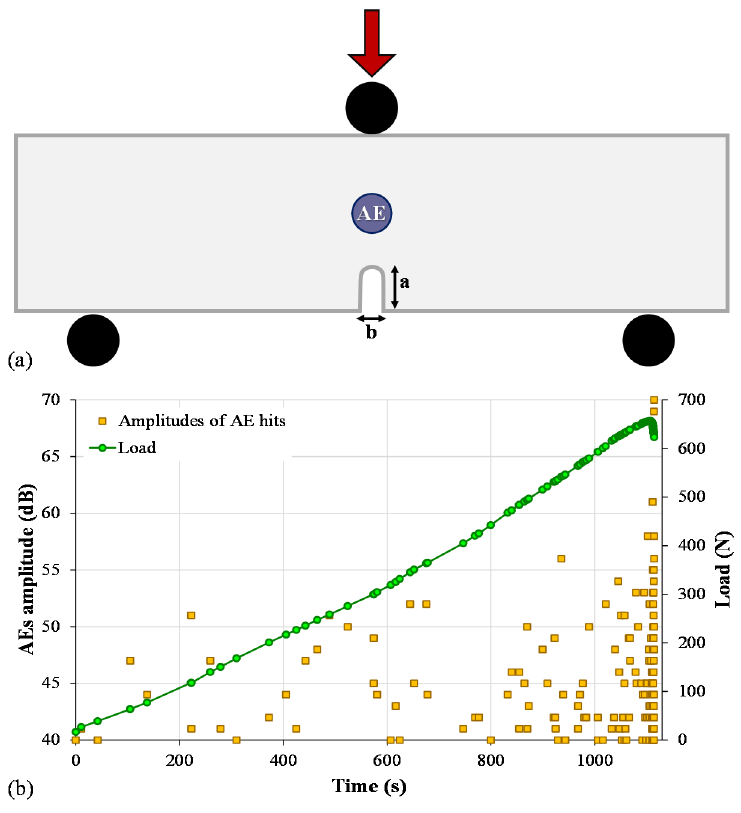
Figure 4. ( a ) Sketch of the notched prismatic specimen. The red arrow indicates the direction of the imposed load, and the black circles represent the cylinders used to apply the load. ( b ) The temporal evolution of the amplitudes of the acoustic hits in juxtaposition to that of the force imposed.